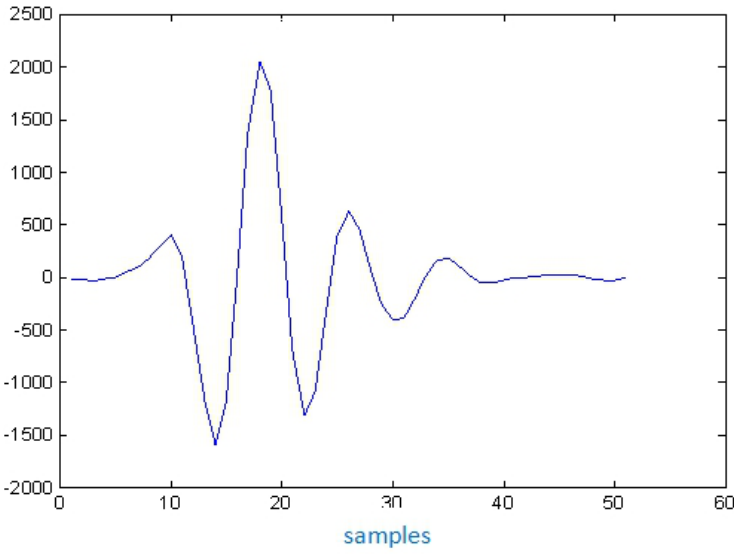
Figure 4. Echo waveform in typical pulsed ultrasonic inspections, measured with a 10 MHz transducer, at the interface between water and a low acoustic attenuation material mimicking an arterial